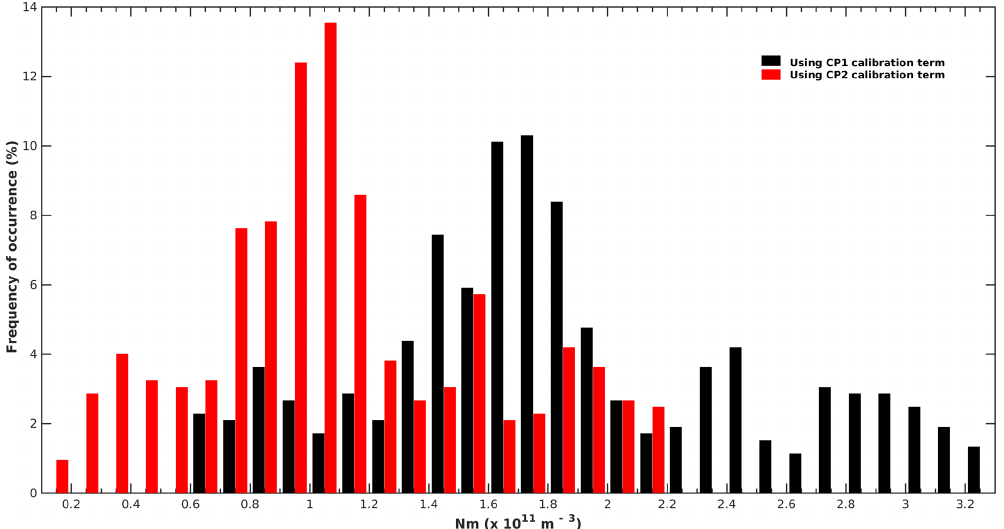
Figure 3. Frequency of occurrence of derived Nm over Allahabad based on 14 nights of data during September–December 2009. Nm values derived from OI 777.4nm emission intensity using CP1 and CP2 calibration terms are shown by black and red bars, respectively. Table 2. Comparison of the critical frequency of F2 layer (foF2) and corresponding peak of maximum electron density (hmF2) inferred from OI 777.4 and 630.0nm emission intensity with the ionosonde measurements (foF2 and hpF2) on 16 September 2009. Time Airglow observations Ionosonde measurements Case I (CP1) Case II (CP2) foF2 hmF2 foF2 hmF2 Time foF2 hpF2 (in MHz) (km) (in MHz) (km) (in MHz) (km)